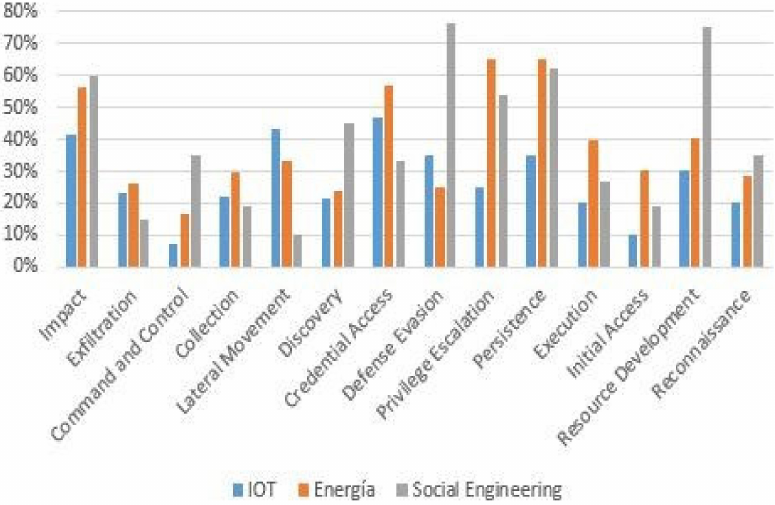
Figure 8. Techniques MITRE used in vertical domains such as Energy, Social Engineering, and